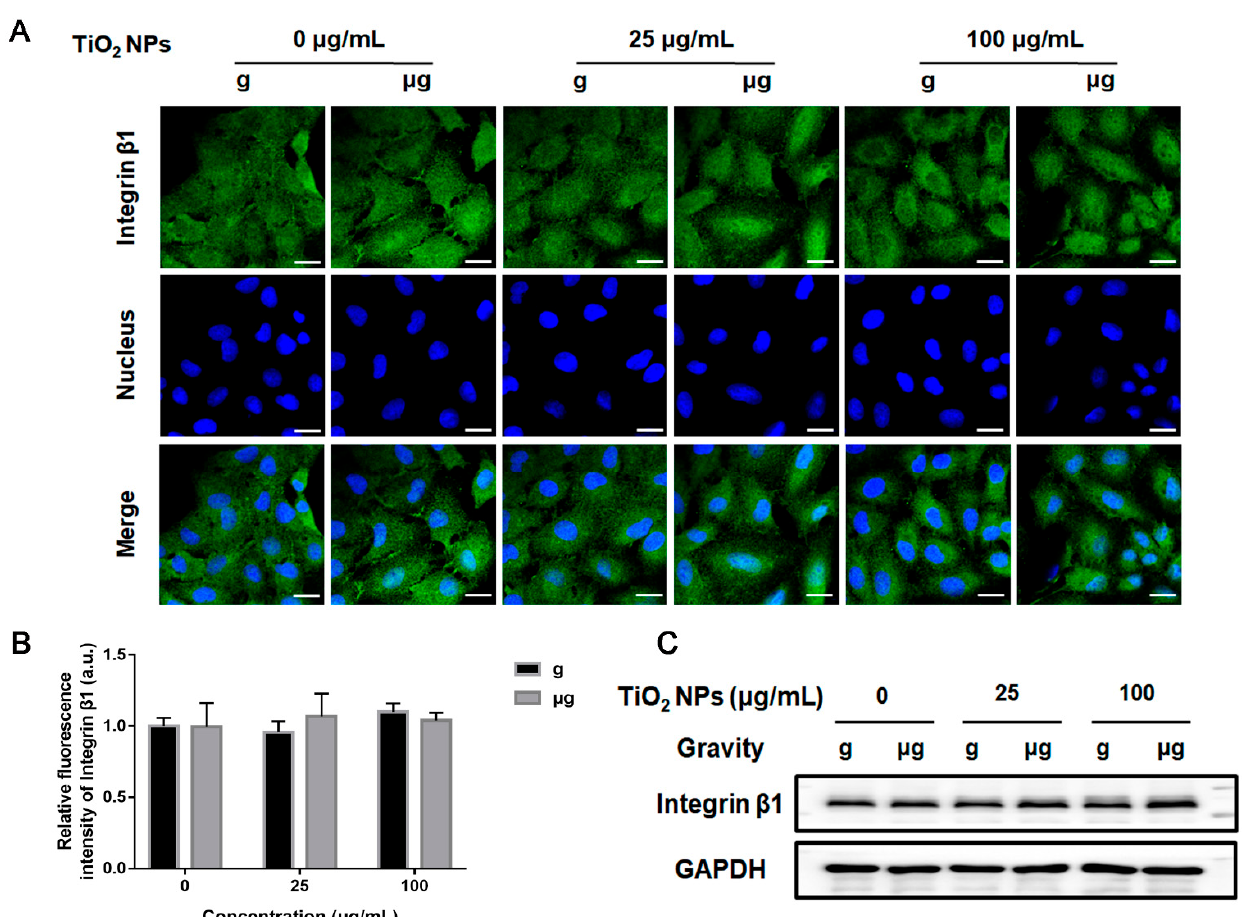
Figure 8. Effect of TiO 2 NPs exposure on the expression level of integrin β 1 upon different treatments. A549 cells were treated with TiO 2 NPs (0, 25 and 100 µ g/mL) for 48 h under normal gravity (g group) or simulated microgravity ( µ g group). ( A ) The harvested cells were immune-stained for integrin β 1 observation. DAPI was used to stain the nuclei. Representative immunofluorescence images were demonstrated here (scale bar; 20 μ m). ( B ) The quantitative analysis of fluorescence intensity of each group. ( C ) The representative results of Western blot analysis.